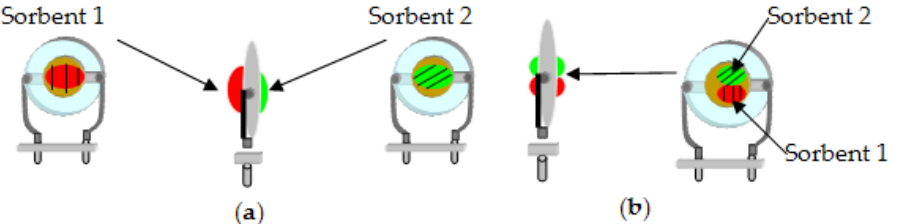
Figure 1. Technique of the formation of polycomposite coatings: isolated deposition—( a ), joint deposition—( b ).